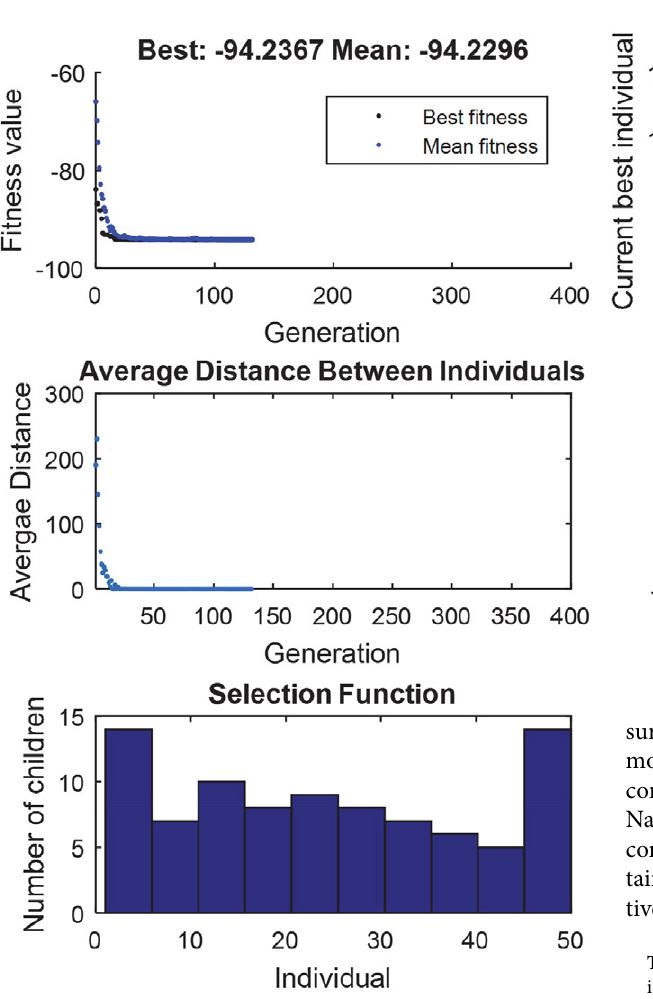
Figure 9. The optimization steps of adsorption parameters using genetic